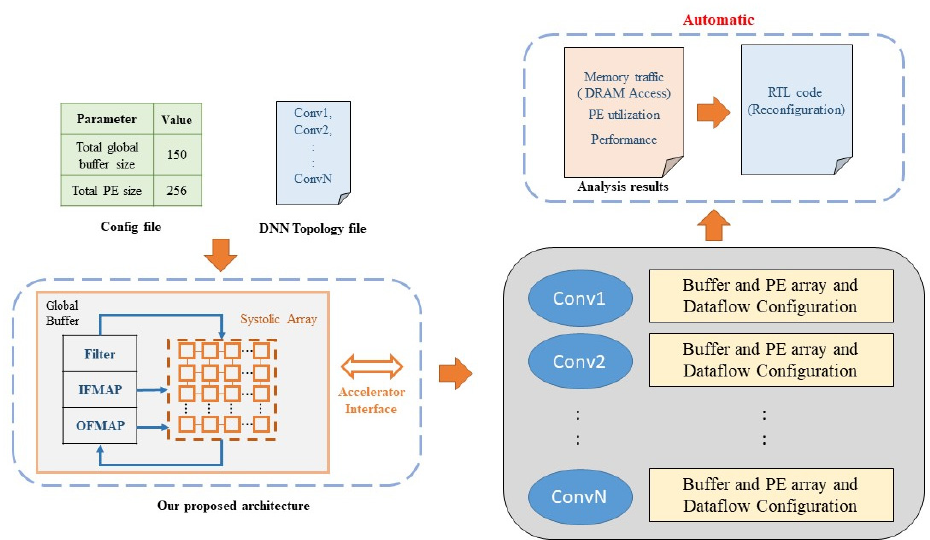
Figure 4. The proposed exploration platform.